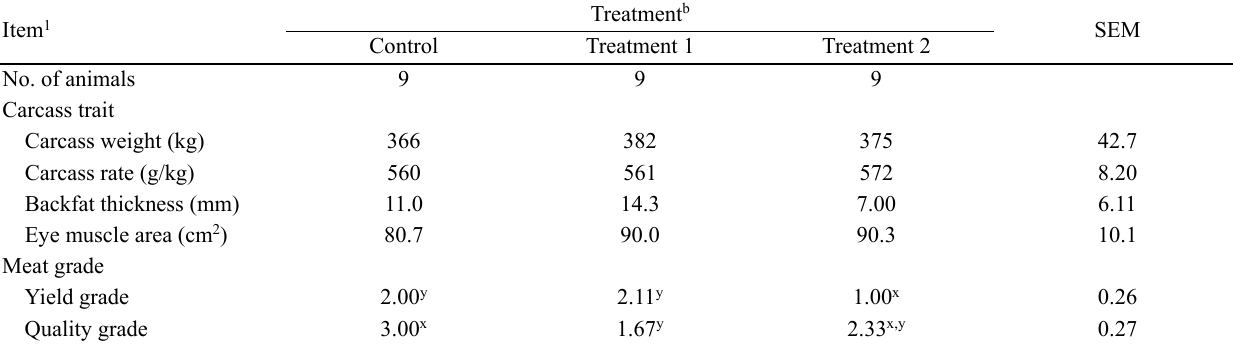
Table 5. Substitution effect of a total mixed ration by medicinal plant by-products on the carcass traits and meat grades in the late fattening period of Hanwoo